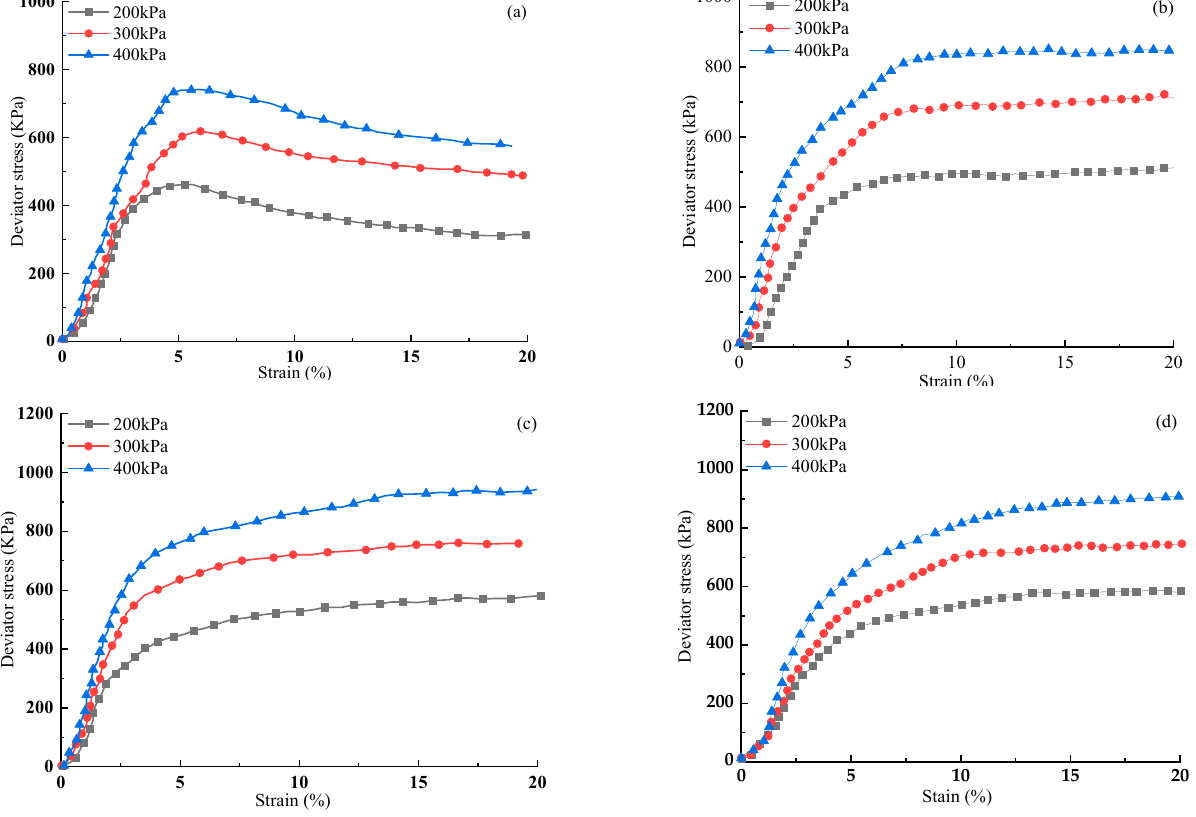
Figure 5. The relation of stress–strain curves of ( a ) unreinforced specimen and FAS mixtures with 0.5% FC and: ( b ) FL = 6 mm, ( c ) FL = 12 mm, ( d ) FL = 24 mm under different confining pressures.